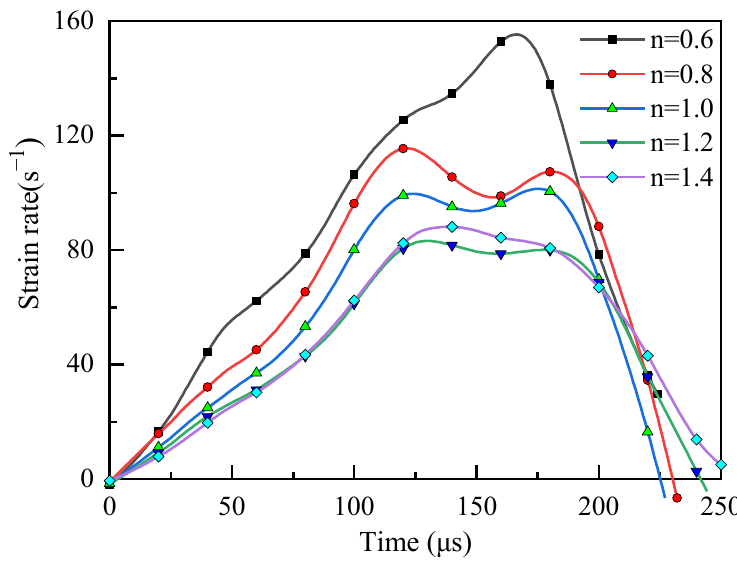
Figure 13. Strain rate curves of different length–diameter ratios with strain rate of 156.8 s −1 .